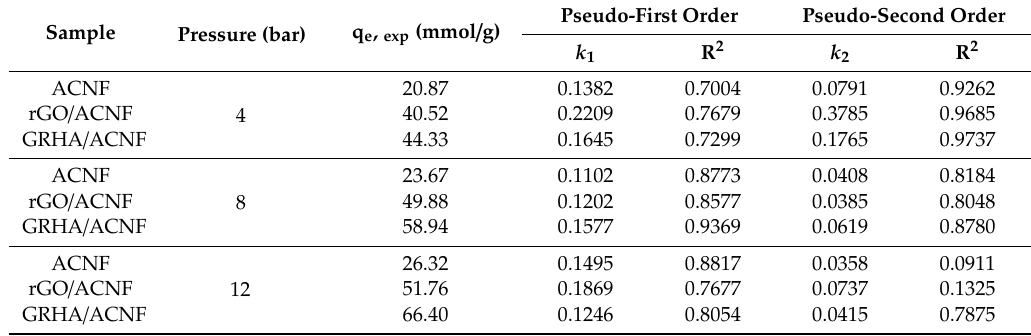
Table 4. Kinetic parameters of pseudo-first-order and pseudo-second-order for ACNF, rGO / ACNF, and GRHA / ACNF at di ff erent adsorption